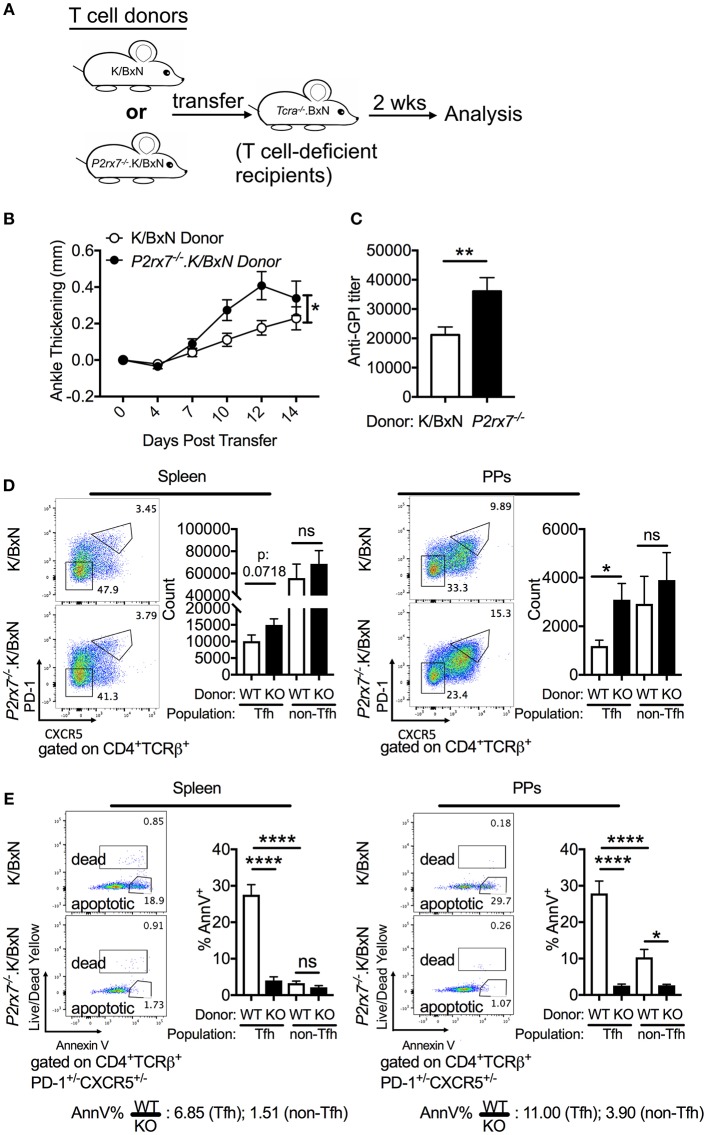
P2rx7−/− T cells enhance autoimmunity in the SFB(–) K/BxN T cell transfer model. (A–E) CD4+ T cells were isolated from either WT K/BxN or P2rx7−/−.K/BxN donors and transferred to TCRα−/−.BxN recipients. (A) Schematic for T cell transfer. (B) Arthritis development was followed by ankle measurements starting at the day of transfer (day 0). Values are shown as averages of the change in ankle thickness for each individual compared to its first measurement. N = 20–24/group, 5 assays combined. (C) Auto-Ab titer as determined by ELISA against GPI. N = 20–24/group, 5 assays combined. (D) Representative plots and compiled graphs of Tfh and non-Tfh cell numbers in spleen and PPs. N = 15–18/group, 4 assays combined. (E) Representative plots of Tfh and non-Tfh cells stained for Annexin V and Live/Dead Yellow and compiled graphs of Live/Dead Yellow− Annexin V+ Tfh or non-Tfh cells as a percentage of total Tfh or non-Tfh cells in spleen and PPs. WT = K/BxN, KO = P2rx7−/−.K/BxN. Ratios determined by dividing the average of the WT group by the average of KO group. N = 8–11/group, 3 assays combined. *p < 0.05 **p < 0.01 ****p < 0.0001.